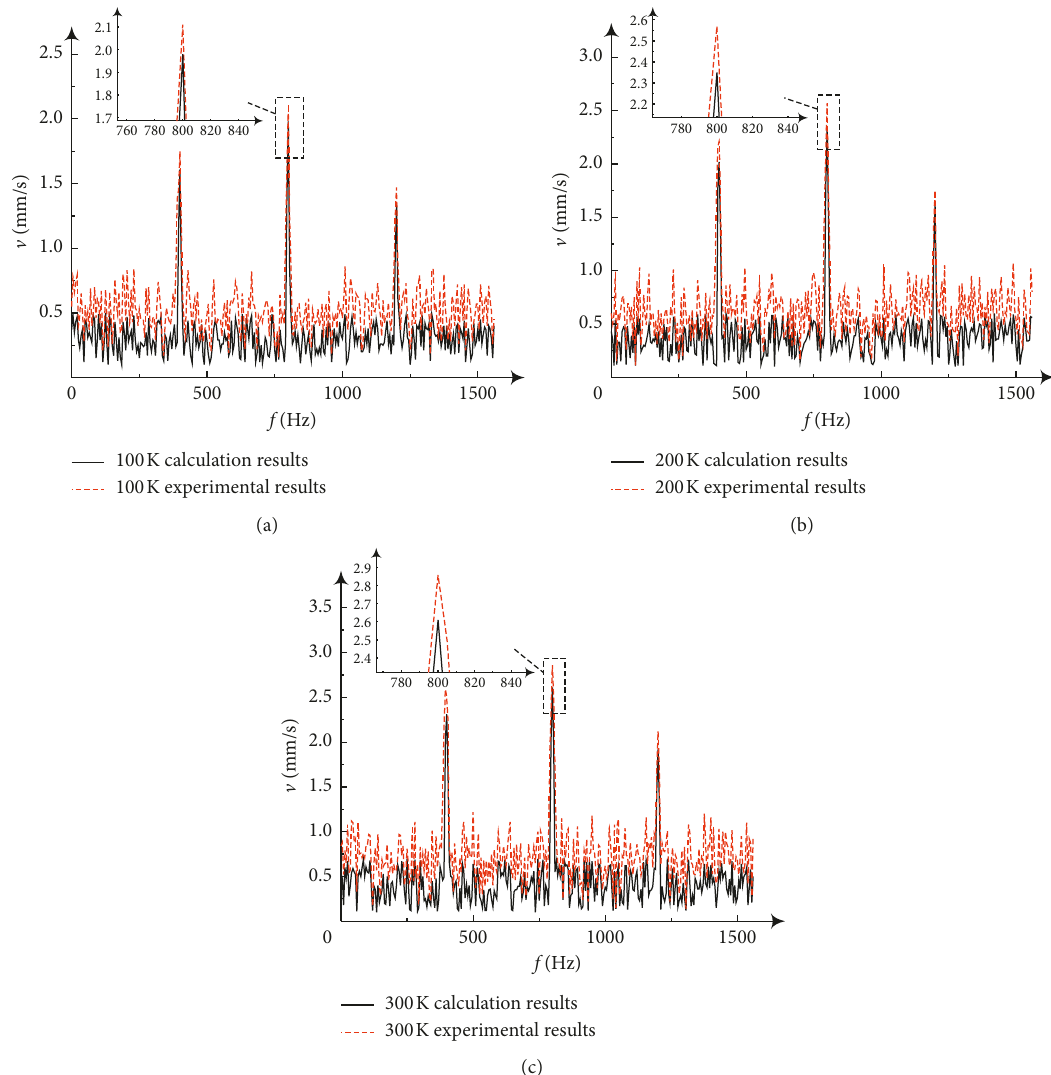
Figure 8: Calculation and experimental results at (a) 100K, (b) 200K, and (c)